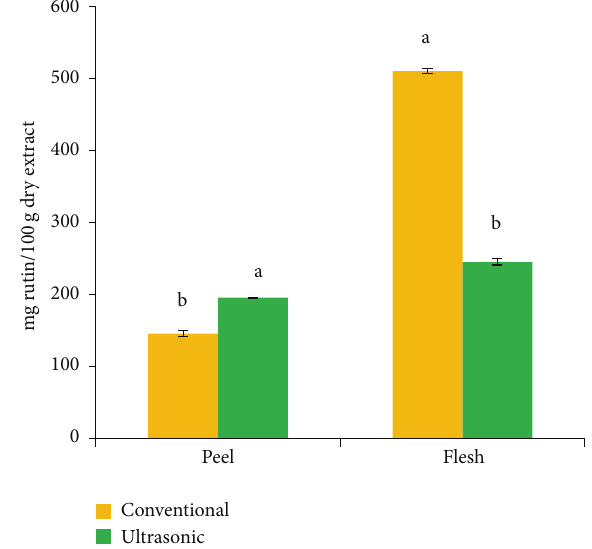
Figure 2: Total flavonoid contents extracted from red dragon fruit of different parts by using different methods. (Mean with different alphabets for the same plant parts are significantly different ( 𝑃 < 0.05 ).)